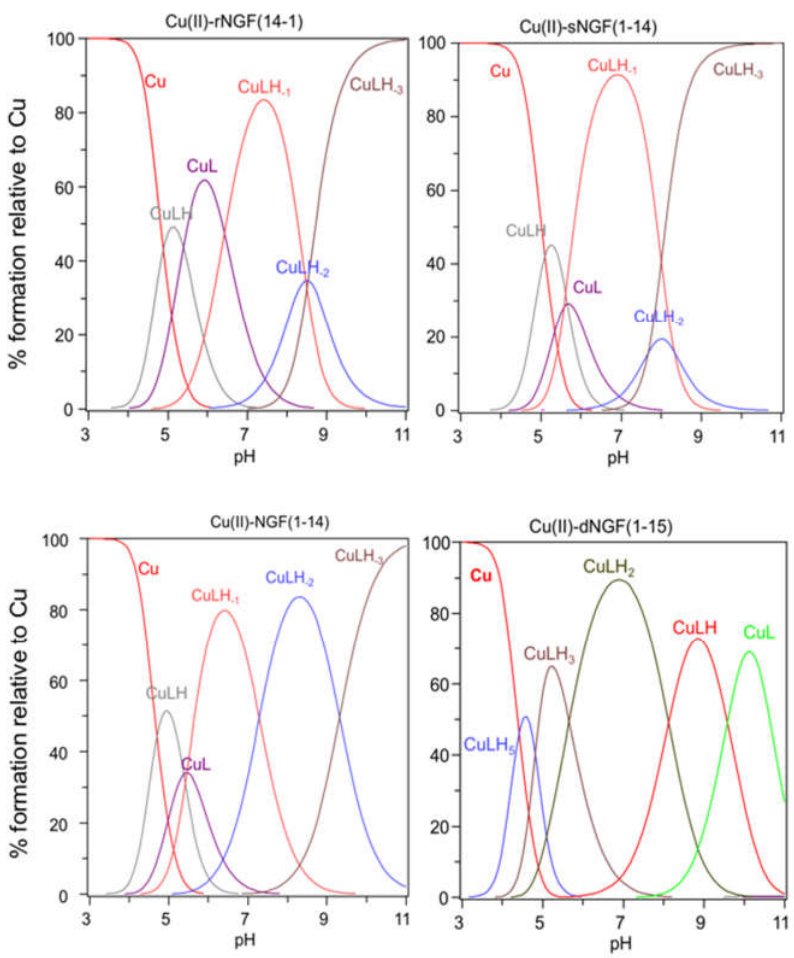
Figure 2. Species distribution of copper(II) complexes with rNGF(14-1), sNGF(1-14), NGF(1-14) and dNGF(1-15). [L] = 1 × 10 −3 M; metal to ligand molar ratio of 1:1. Spectroscopic parameters measured at pH = 5, confirm the 2N Im ,COO − coordina- ( λ max = 640 nm, ε = 64 M − 1 cm − 1 ) compared to scrambled peptide ( λ max = 670 nm, ε = 40 M − 1 cm − 1 ) (Table 3). However, it must be underlined that the parameters are partly influenced by the presence of other species other than free